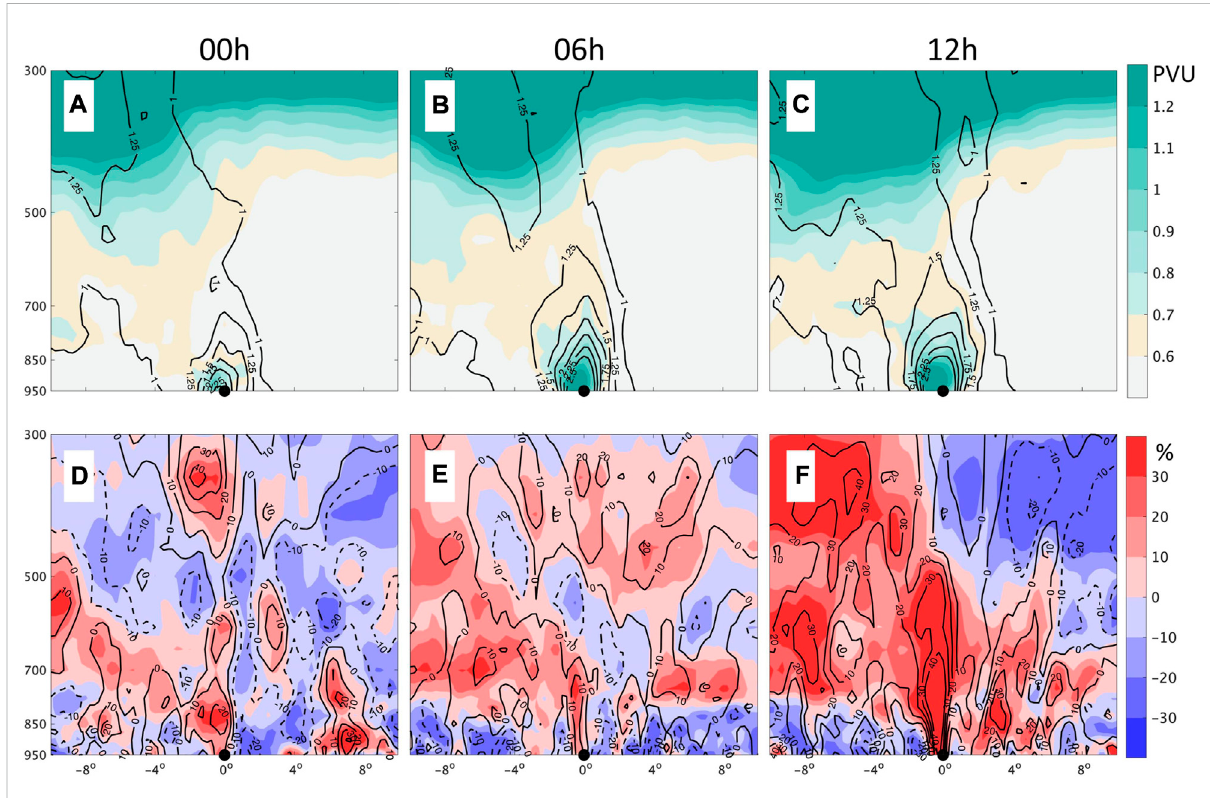
FIGURE 6 Zonal cross sections of the average PV and relative vorticity going through the cyclone center (denoted by the black dots) during initial development. The fi rst row shows the average PV (shadings) and relative vorticity (contours; unit: 10 − 4 s − 1 ) for OCs. The second row shows the difference in PV (shadings) and relative vorticity (contours; unit: %) between ECs and OCs, with solid/dashed lines denoting relative vorticity for ECs larger/smaller than OCs. The left/middle/right column shows the situation 0/6/12-h after the cyclones are identi fi